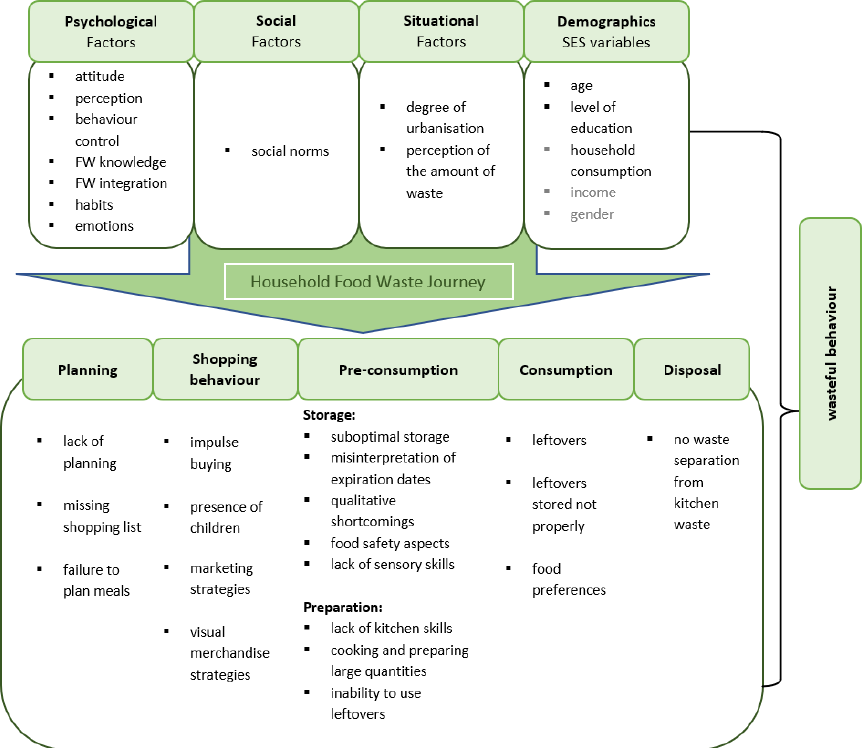
Figure 4. Model for explaining the generation of FW in households. Source: Own illustration. Based on Principato, 2018 [23]. Additions in grey letters.